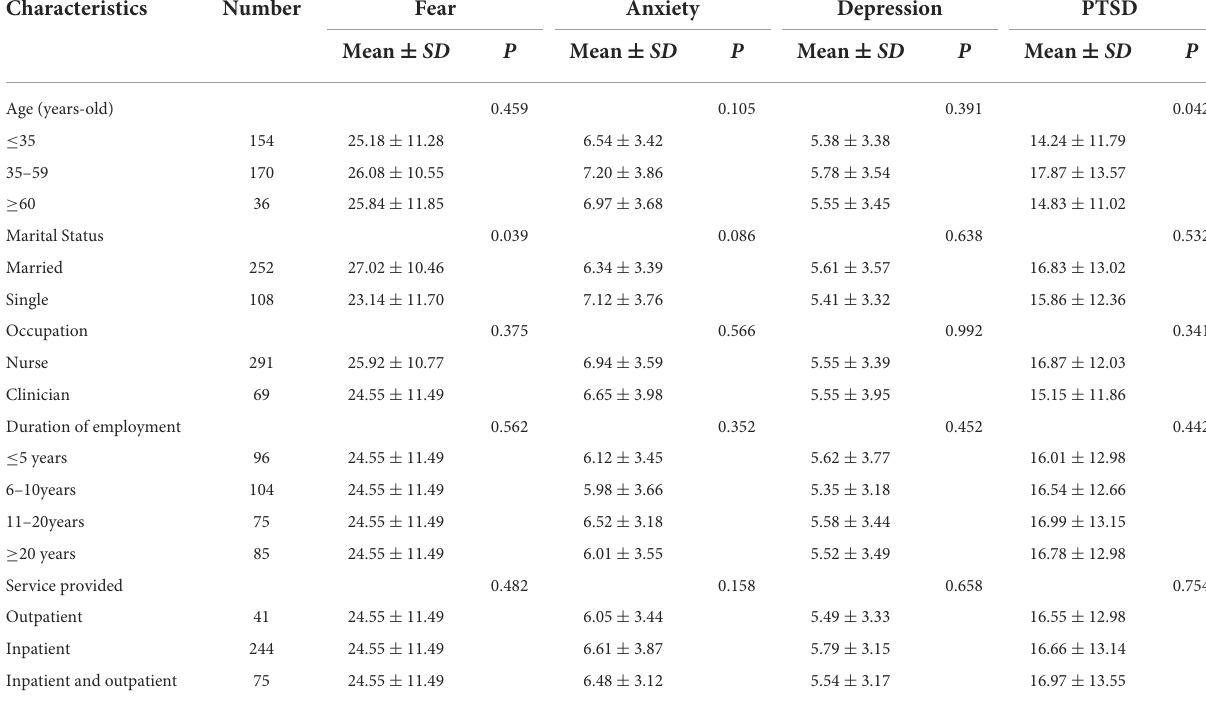
TABLE 4 Association between fear, anxiety, depression, PTSD, and clinical characteristics of female HCWs.